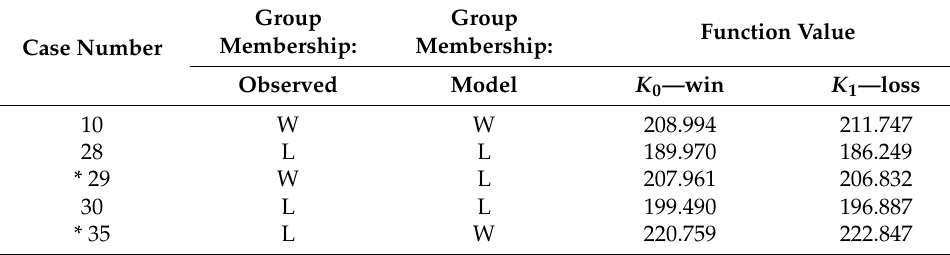
Table 12. Classification function values for selected